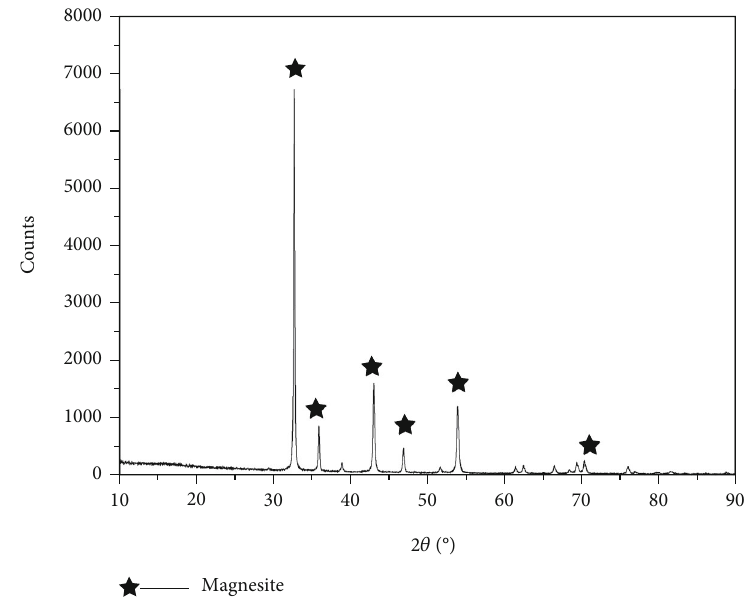
Figure 1: X-ray di ff raction pattern of the magnesite sample.